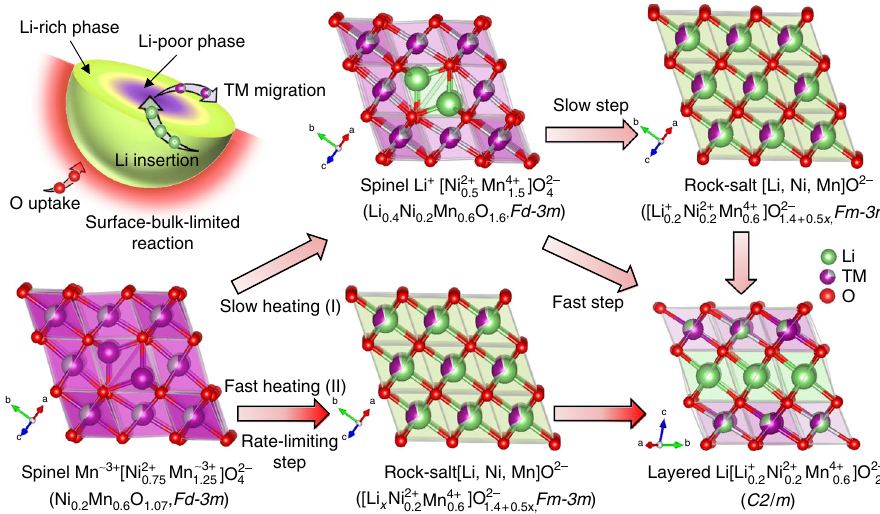
Fig. 6 Two distinct pathways of Li-rich layered oxide formation from Li-free spinel oxide. Schematic diagram of lithium- and oxygen-incorporation-induced structural and electrical evolution during synthesis of layered Li[Li 1.2 Ni 0.2 Mn 0.6 ]O 2 cathode materials, revealing the formation mechanisms of Mn-rich cathodes during slow (I) and fast (II) thermal treatments, and the possible origin of voltage decay in high-energy lithium-excess layered oxides, i.e., a kind of partially reversed formation pathway (II) of LMLOs under non-equilibrium conditions (lithium extraction accompanying oxygen